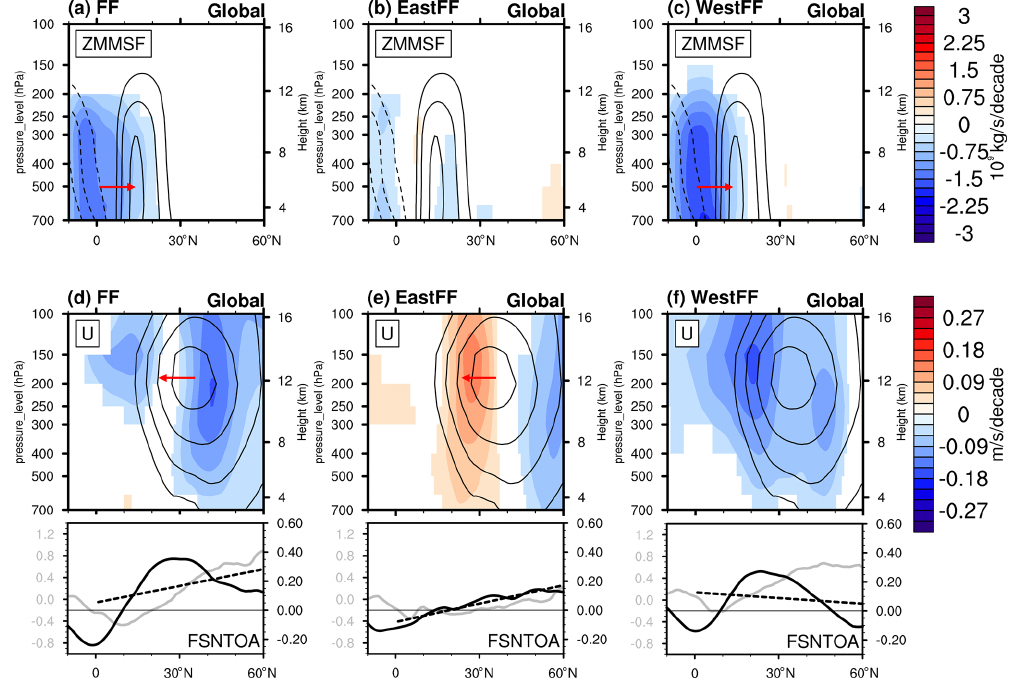
Figure 6. Panels (a–c) show the 1980–2020 trend of zonal mean meridional stream function (ZMMSF; 10 9 kgs − 1 per decade) in response to (a) FF, (b) EastFF, and (c) WestFF. The positive values (solid lines for climatology and red shading for the long-term trend) indicate clockwise circulation. The statistically insignificant trend is masked in white. The arrows indicate the latitudinal shift of the Hadley cell. Panels (d) – (f) are similar to panels (a) – (c) but for zonal mean zonal wind ( U ; meters per second per decade; hereafter ms − 1 per decade). The positive values indicate westerly wind. The arrows indicate the latitudinal shift direction of the NH jet stream core. The latitudinal profiles below show the top-of-atmosphere net solar flux trend (FSNTOA as in Fig. 5c; Wm − 2 per decade) and the gradient of FSNTOA trend (black curves; Watts per square meter per decade per 10 ◦ latitude; hereafter W/m 2 per decade per 10 ◦ lat). The trend and gradient lines are smoothed using the moving average method (with 30 ◦ of the latitudinal range sampling window). The dashed lines are the linear fit from 0 to 60 ◦